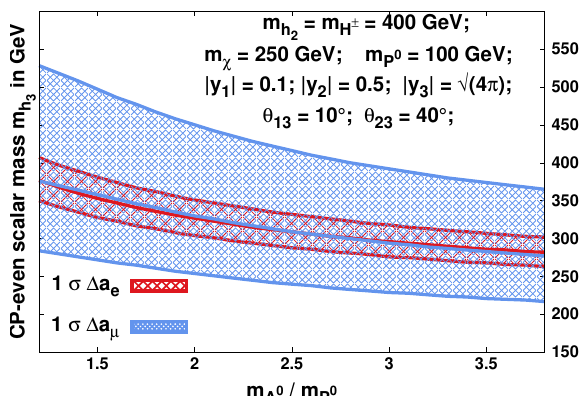
Figure 10. Colored solid contours and associated one sigma bands are shown in m h − m /m plane satisfying ∆ a µ = (251 ± 59) × 10 − 11 [3] (in blue) and ∆ a e = A 0 P 0 3 [ − 88 ± 28 (expt . ) ± 23 ( α ) ± 2 (theory)] × 10 − 14 [11] (in red). The overlap of the two bands de- pict the common parameter